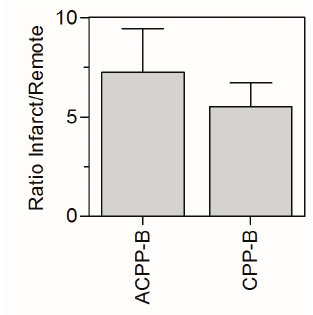
Figure 7. Infarct-to-remote ratio for 177 Lu-ACPP-B and 177 Lu-CPP-B. The data are mean ±